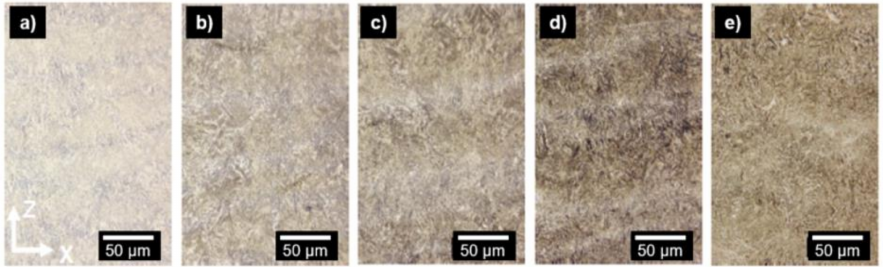
Figure 5. Microstructure depending on the carbon content achieved with graphite powder at 500 × magnification, ( a ) 0.15 wt.% C (reference), ( b ) 0.3 wt.% C, ( c ) 0.4 wt.% C, ( d ) 0.5 wt.% C, ( e ) 0.8 wt.% C.